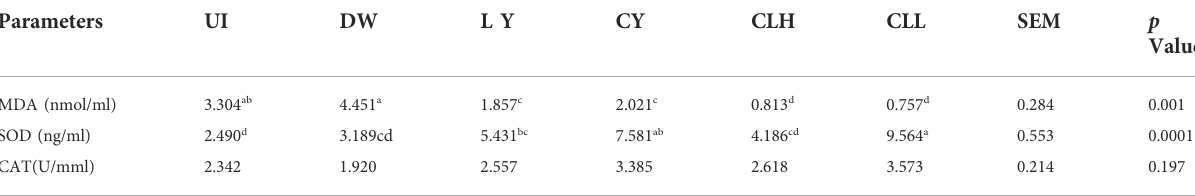
TABLE 3 Effect of in ovo cysteine and lysine on plasma catalase, MDA, SOD of day-old chicks. Parameters